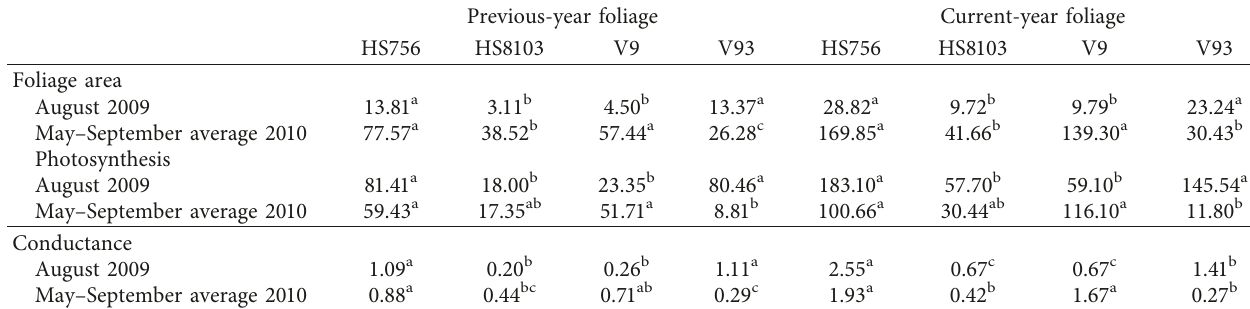
Table 4: Crown foliage area (m 2 ), light-saturated photosynthesis ( µ mol · m − 2 ), conductance (mmol · s − 1 ), and transpiration (mmol · s − 1 ) of previous-year and current-year foliage of loblolly pine genotypes at a site in North Central Louisiana in August 2009 and in 2010 (averaged for May, June, August, and